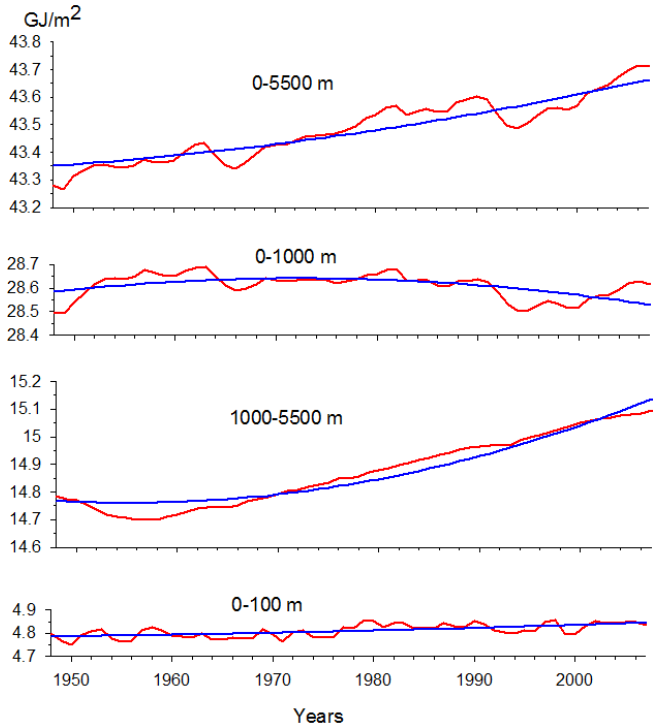
Figure 1. Time series of the WO heat content and its quadratic trend for the period of 1948–2007 in the layers 0–5500, 0–1000, 1000–5500, and 0–100